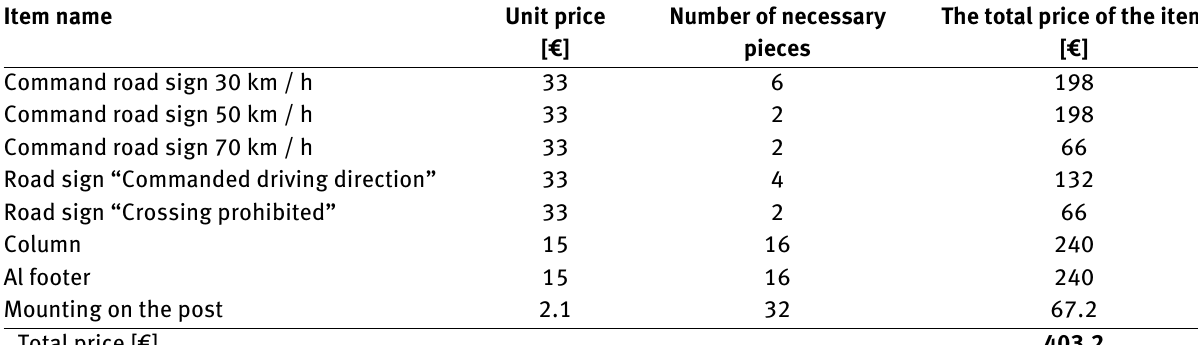
Table 1: Funds for the bypass variant - road signs Item name